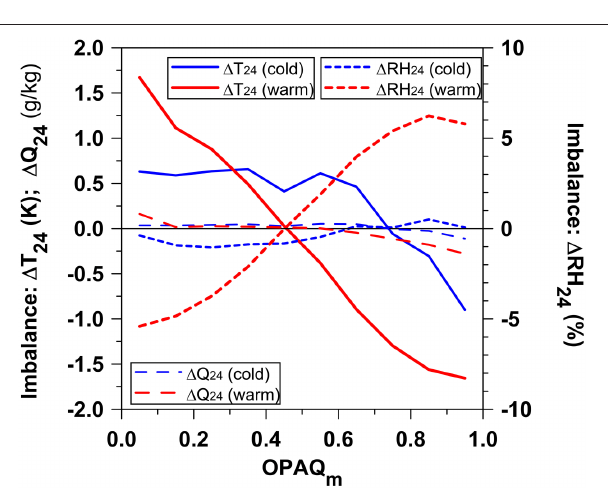
FIGURE 11 | Twenty-four hours imbalance of T, RH, and Q for warm and cold composites.